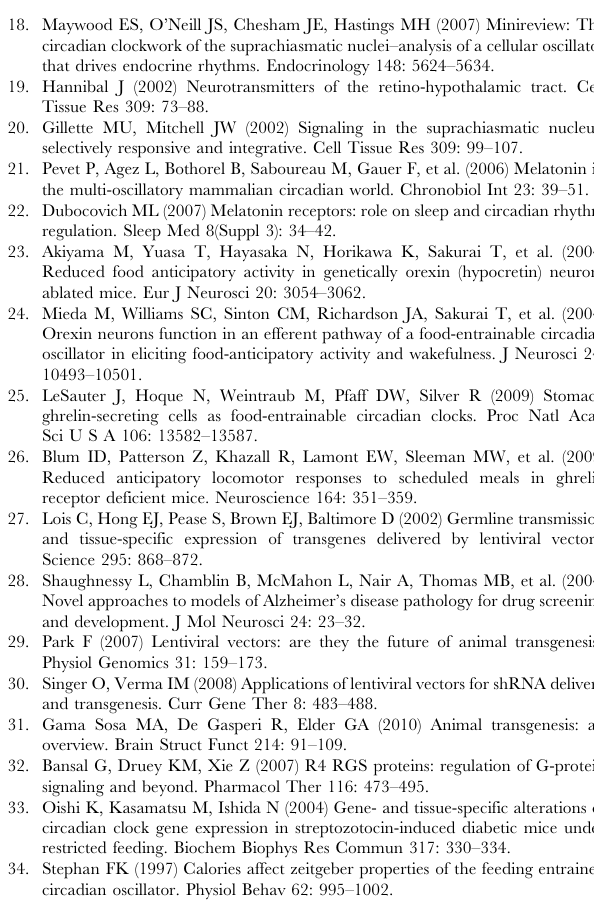
Figure S2 In vitro knockdown of the Rgs16 mRNA by shRNAs used in this study. 2 m g of the pSilencer 1.0 vector expressing either of the two shRNAs ( # 41 or # 53) was transfected into the NIH3T3 mouse fibroblast cell line with Lipofectamine 2000. RNA was extracted from each of the transfected cells two days after the transfection, and expression levels of Rgs16 were compared by qPCR (see Materials and Methods). Both # 41 and # 53 shRNAs significantly reduced the average Rgs16 mRNA level (** P , 0.01, n